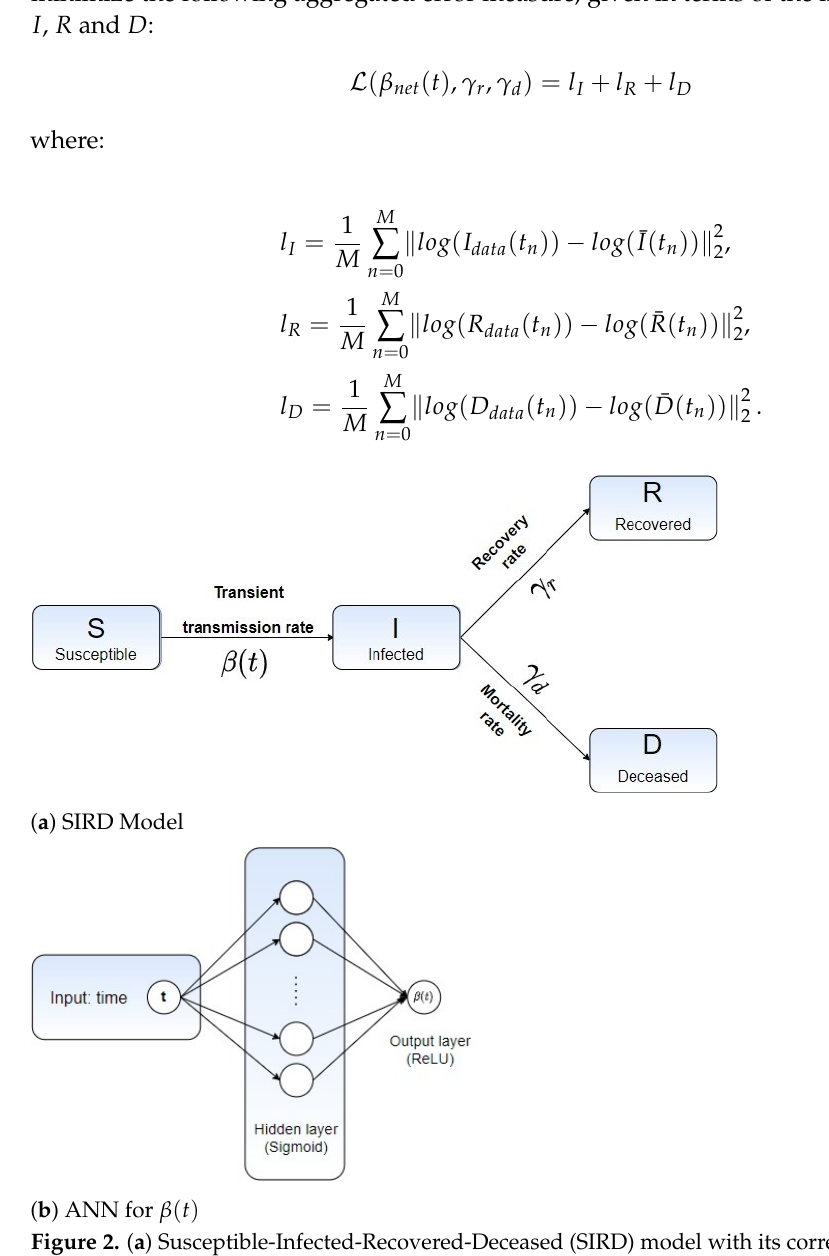
Figure 2. ( a ) Susceptible-Infected-Recovered-Deceased (SIRD) model with its corresponding parame- ters and ( b ) the ANN design for learning β ( t )